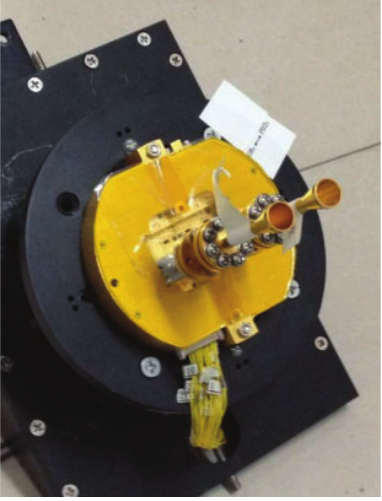
Figure 5: W-band measurement radar.